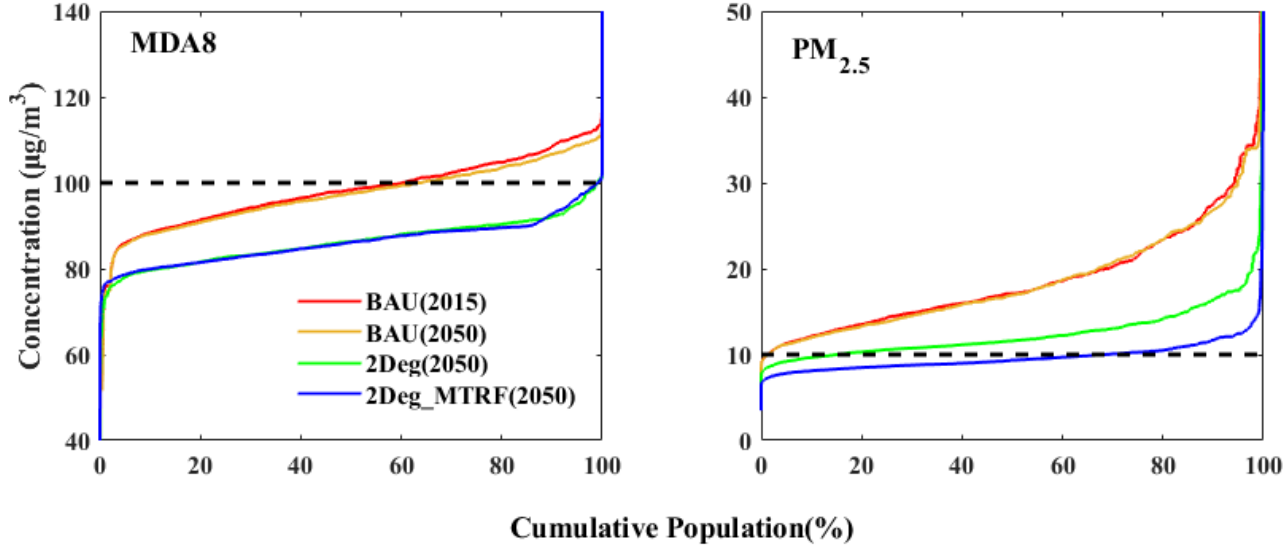
Figure 5. The cumulative distributions of annual mean PM 2.5 and MDA8 exposures under the different scenarios.